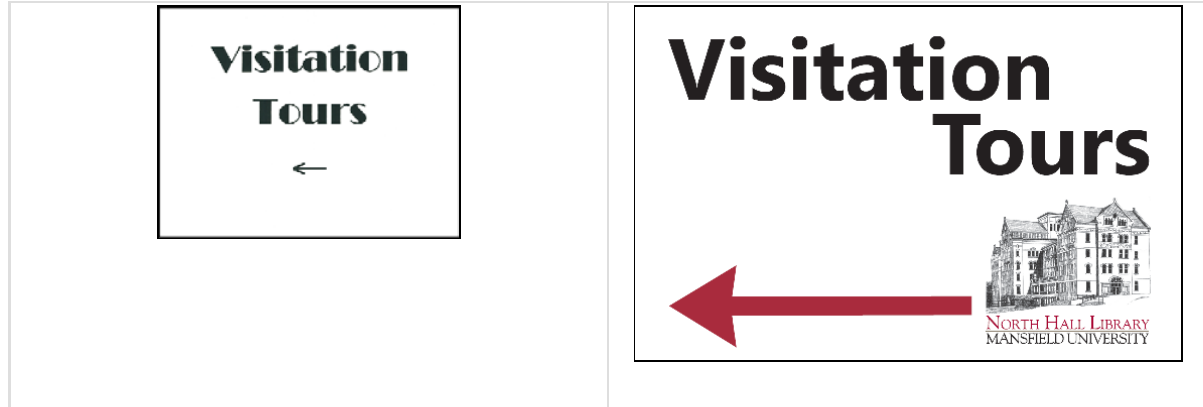
As seen in the original sign (left), fonts that have substantial contrast between the thick and thin parts of the letters are difficult to read, particularly at a distance where the thin parts disappear into the background. The arrow is too small to see at a distance. A larger sign (right) with a larger arrow and a larger, balanced font make this sign easier to understand and